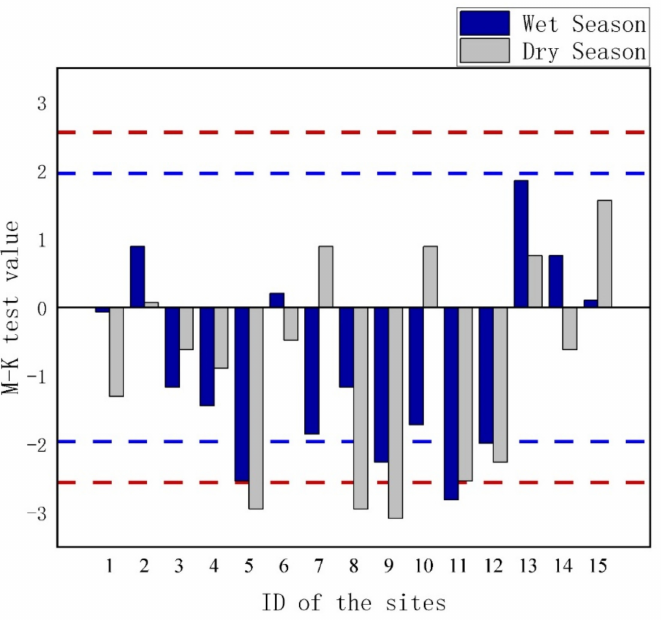
Figure 8. Changing trend in the identification index of comprehensive water quality. The blue line represents a significance level of 0.05, and the red line represents a significance level of